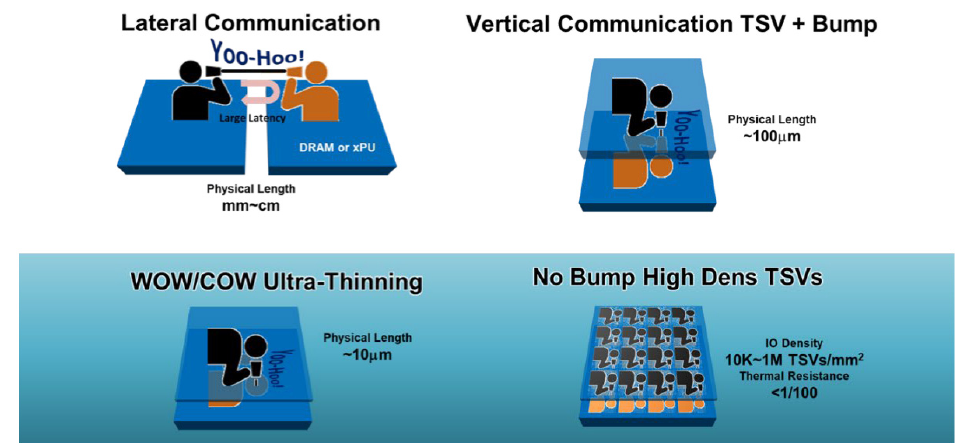
Figure 25. Historical trends and prospect of feature size of transistors, Si wafer area, and semicon- ductor market. See for example; Available online: http://www.wow.pi.titech.ac.jp/index.html (ac- cessed on 25 December 2021).